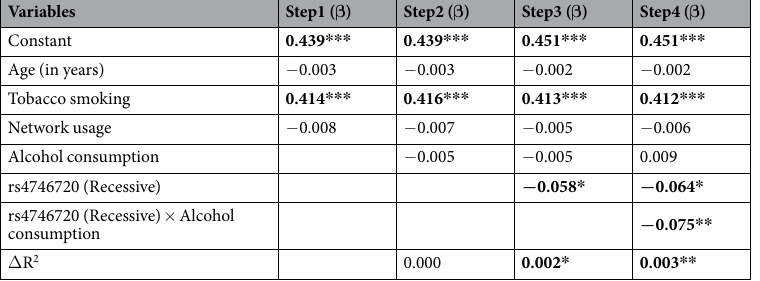
Table 6. Hierarchical regression analysis of the effect of rs4746720 polymorphisms on the relationship between alcohol consumption and ASP. * P < 0.05 (two-tailed), ** P < 0.01 (two-tailed), *** P < 0.001 (two-tailed). Positive results are in bold.